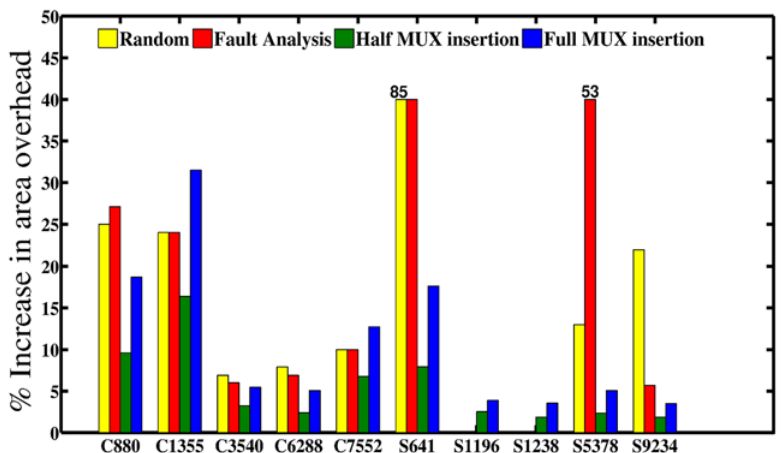
Figure 37. Comparing the power ‐ delay overhead of random, fault analysis, and full/half MUX insertions for logic encryption.